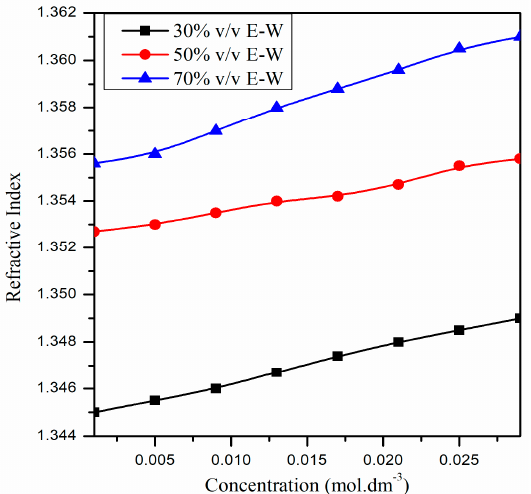
Figure 11. Variation in the RI with the concentration of CIP hydrochloride solutions for different E–W mixtures [59].